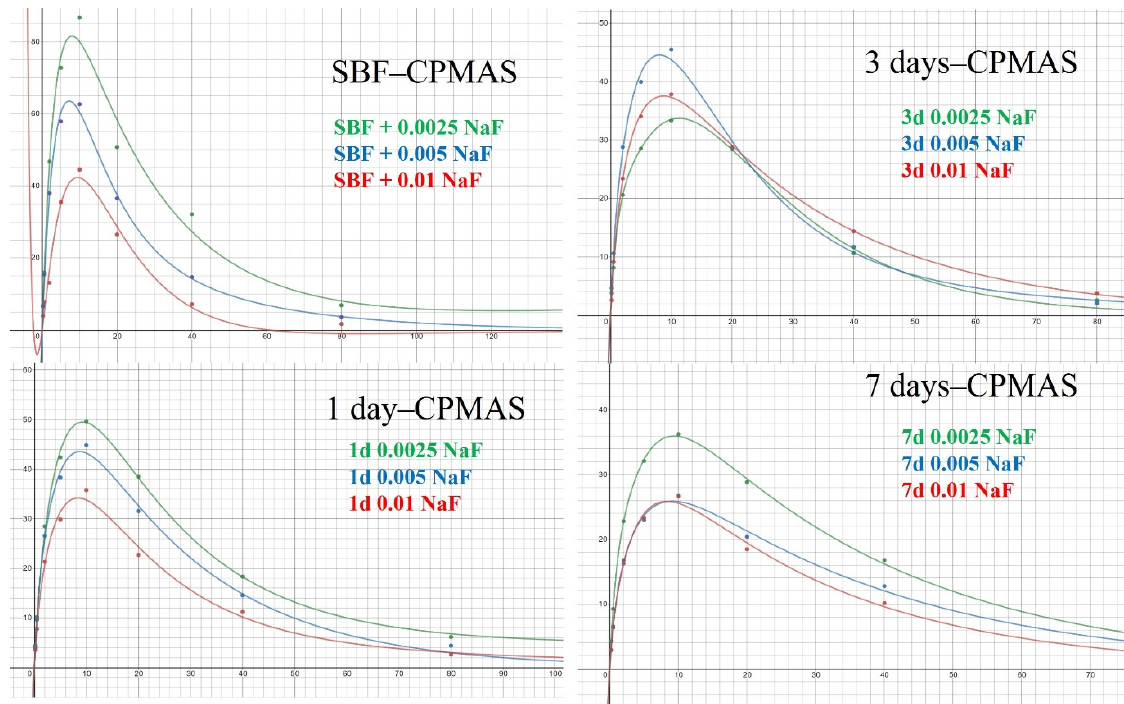
Figure 7. 1 H- 31 P 11 kHz CPMAS spectra of HAp synthesized in SBF and soaked in solutions at different NaF concentrations (2.5 mM, 5 mM, and 10 mM) for different recycle delays (brown: 5 s; green: 320 s).